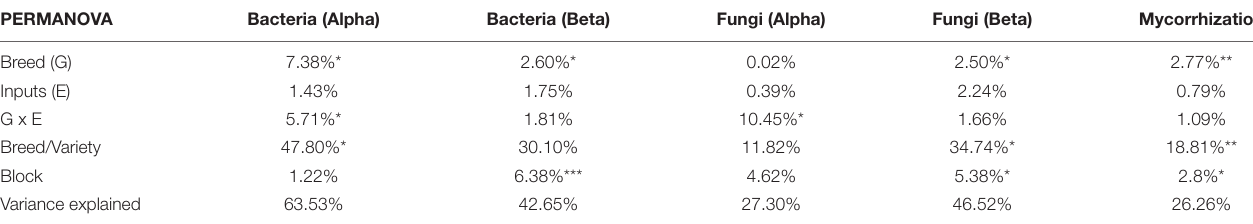
TABLE 2 | Permutational analysis of variance for bacterial and fungal alpha diversity (based on the six diversity indices: richness, Chao-1, ACE, Simpson reciprocal, Shannon, and equitability), beta diversity (based on Bray-Curtis dissimilarity index), and for parameters describing mycorrhizal colonization (F, M, m, A, and a, refer to Materials and methods for a